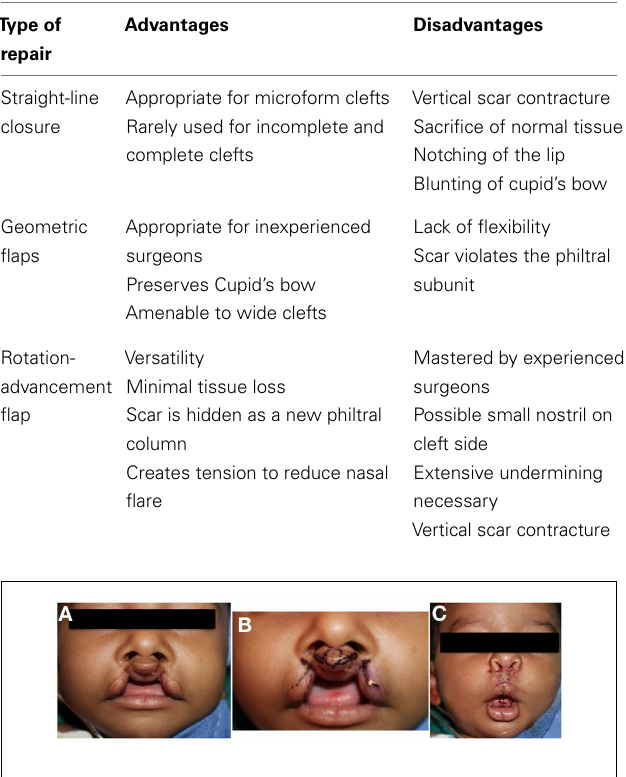
Table 3 | Surgical techniques in cleft lip repair.